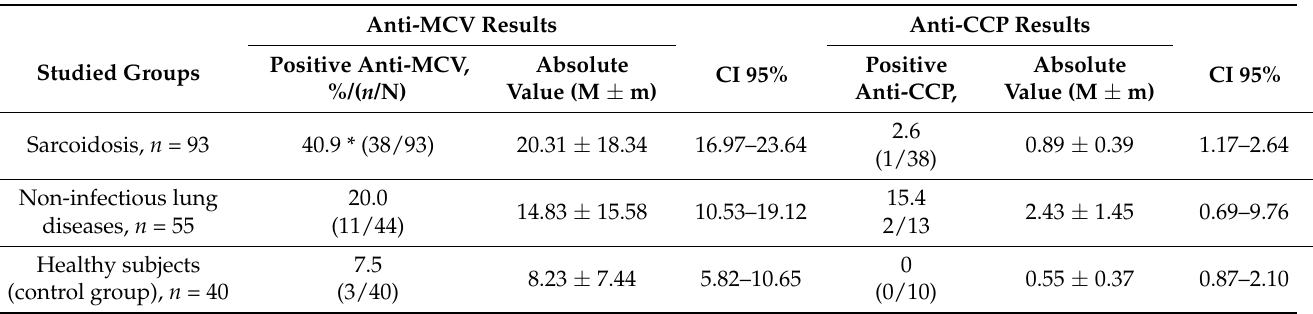
Table 2. Anti-MCV and anti-CCP antibodies in patients with sarcoidosis and non-infectious lung diseases.